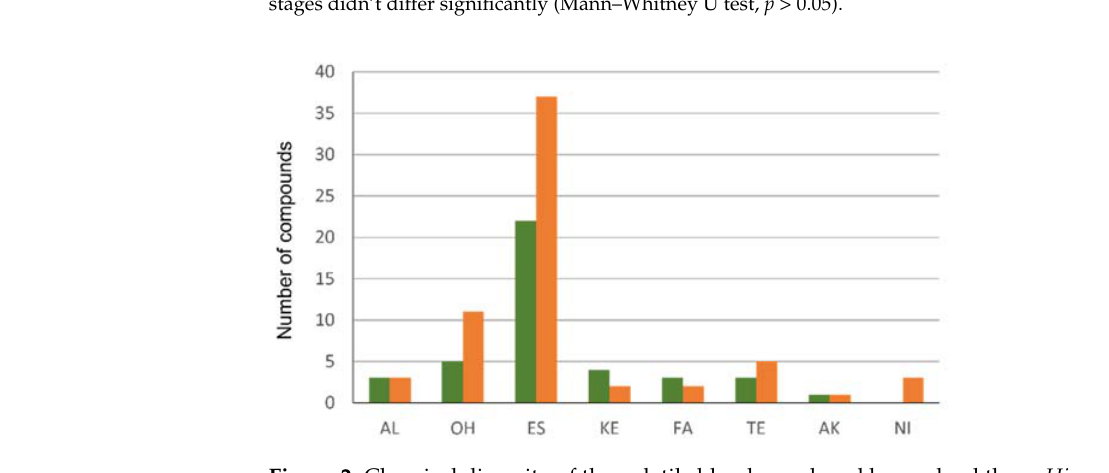
Table 1. Volatile compounds identified in the headspace of sea buckthorn Hippophae rhamnoides fruits at two ripening stages: unripe fruits and ripe fruits.